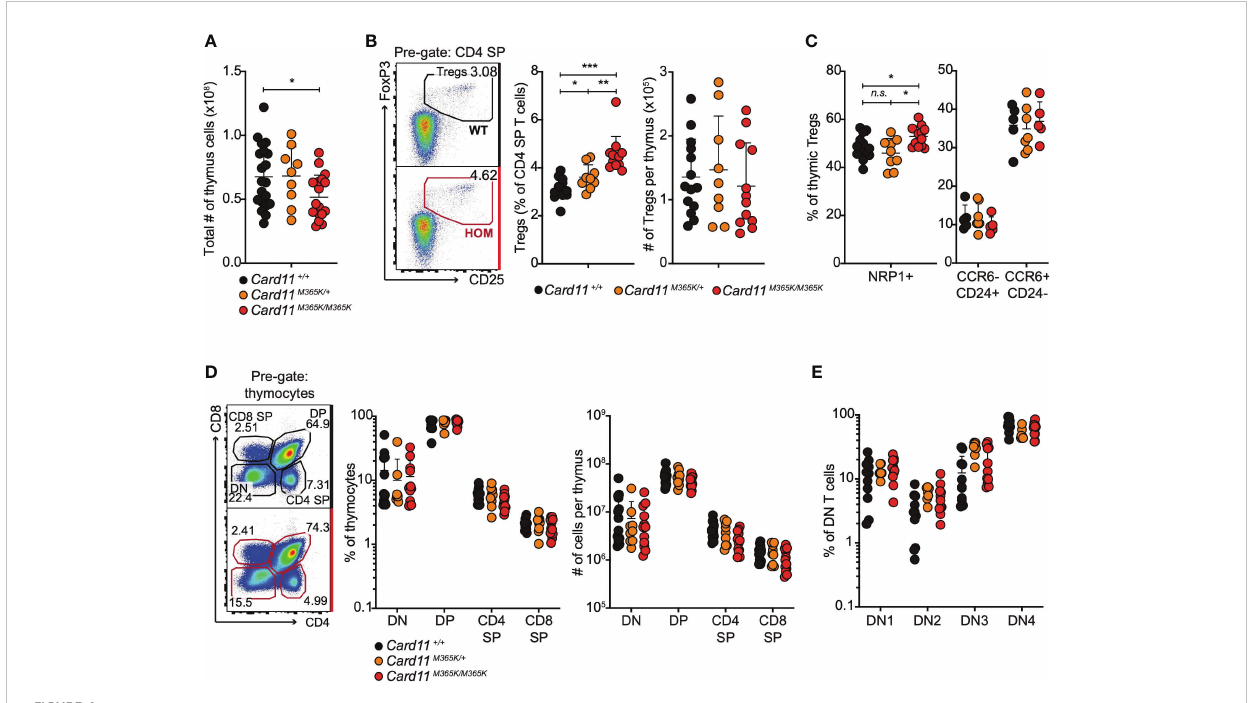
FIGURE 4 Card11 M365K mutant mice have normal numbers of thymic T cell precursors, single positive CD4 and CD8 T cells and T regulatory cells. (A) . Total number of cells per thymus from individual mice of the indicated genotypes. (B) . Left, representative fl ow cytometric analysis and right, percentage amongst CD4 single-positive (SP) T cells or total number per thymus of CD25 + FoxP3 + CD4 + T regulatory (T REG ) cells, in mice of the indicated genotypes. (C) . Percentage of NRP1 + thymic T REGS (left) or of CCR6 - CD24 + or CCR6 + CD24 - thymic T REGS (right), in mice of the indicated genotypes. (D) . Left, representative fl ow cytometric analysis and right, percentage amongst thymocytes or total number per thymus of CD4 - CD8 - double-negative (DN), CD4 + CD8 + double-positive (DP), CD4 + SP or CD8 + SP T cells, in mice of the indicated genotypes. (E) . Percentage of DN T cells with a CD25 - CD44 + DN1, CD25 + CD44 + DN2, CD25 + CD44 - DN3 or CD25 - CD44 - DN4 phenotype, in mice of the indicated genotypes. Statistical comparisons made by t -test, corrected for multiple comparisons using the Holm-Sidak method. Data are representative of n >